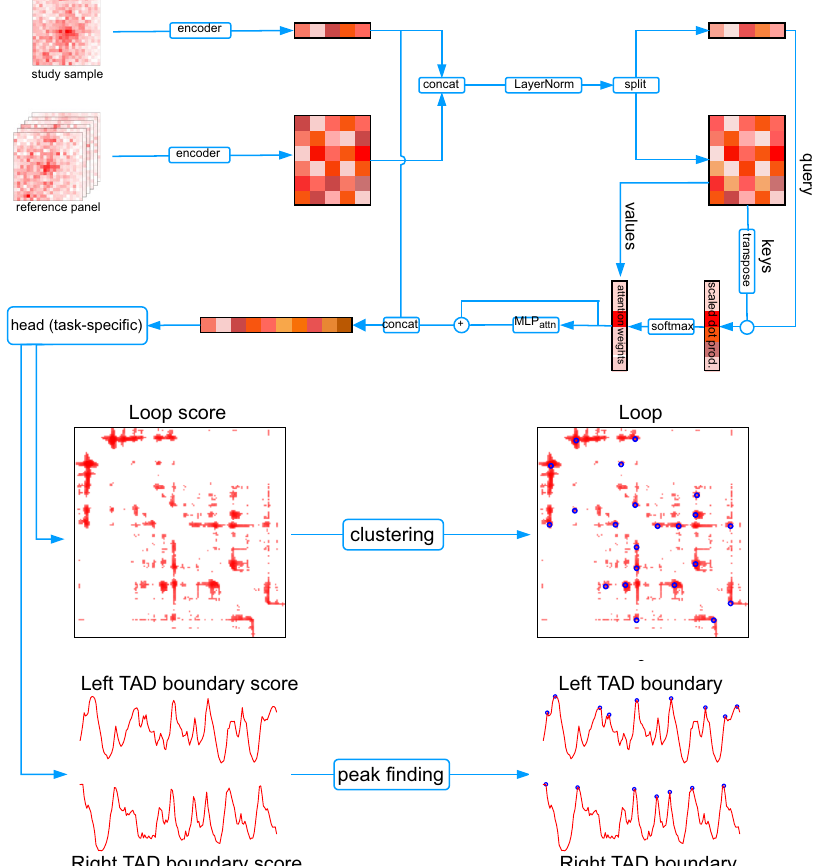
Fig.1|RefHiCarchitecture. OverviewoftheRefHiCneuralnetworkforloopandTADboundaryscoring,followedbyclusteringorpeak fi ndingalgorithmfordiscreteloop and TAD predictions (shown as blue